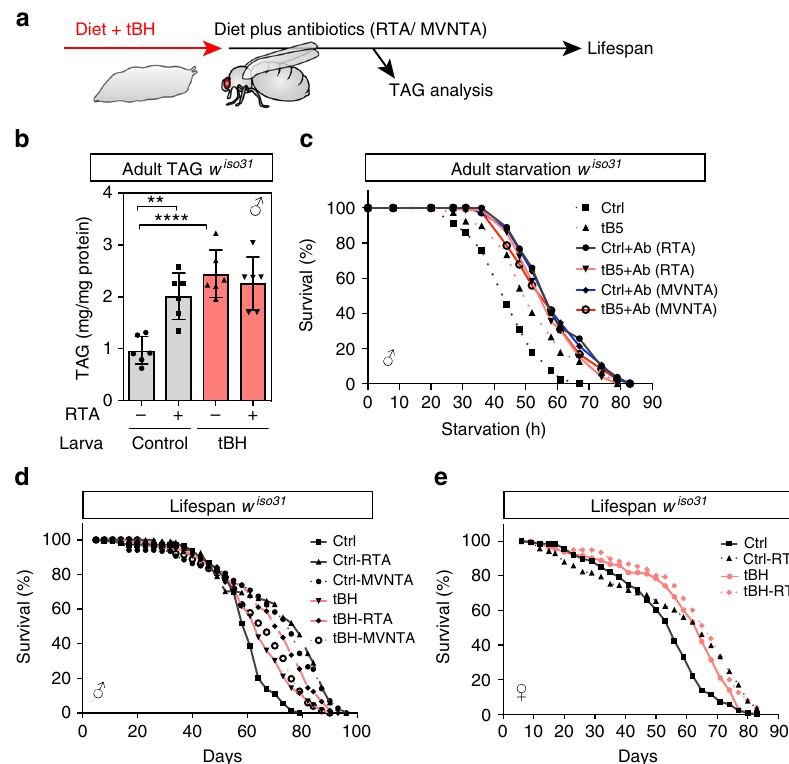
Fig. 6 Adult-onset antibiotics increase TAG, starvation resistance and longevity. a Outline of experimental strategy. b Whole-body TAG (mg/mg protein) of control and tBH-experienced male w iso31 fl ies treated as adults for 6 days with rifamycin, tetracycline and ampicillin (RTA). Mean ± SEM ( n = 6). c Starvation survival curves of male w iso31 fl ies on PBS/agar medium with or without RTA or metronidazole, vancomycin, neomycin, tetracycline and ampicillin (MVNTA). d , e Lifespan of male ( d ) or female ( e ) control or tBH-experienced w iso31 fl ies on standard diet with or without RTA or MVNTA antibiotics. ** p < 0.01, **** p < 0.0001. Statistics for survival curves are shown in Supplementary Table